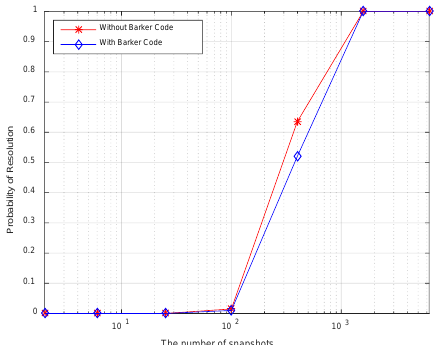
Figure 11. Resolution probability against number of snapshots.